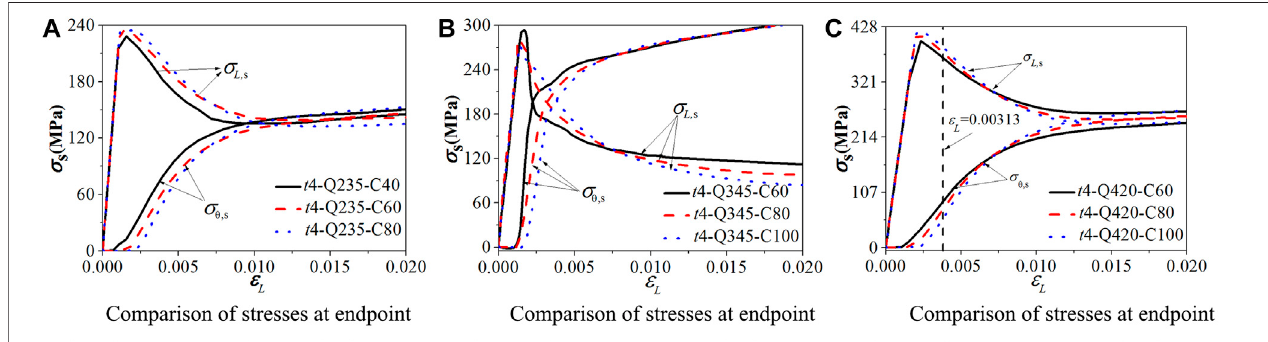
FIGURE 10 | Stress-axial strain curves of steel tube among specimens from FE